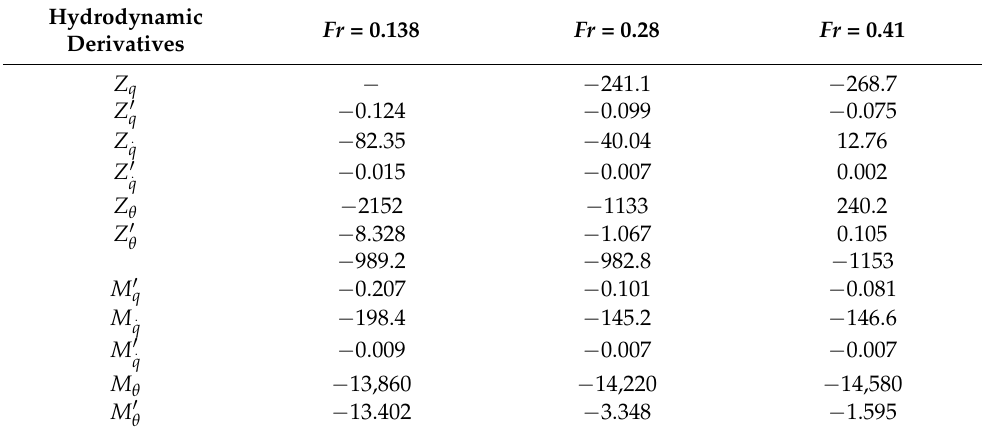
Table 11. Hydrodynamic parameters related to pure pitch